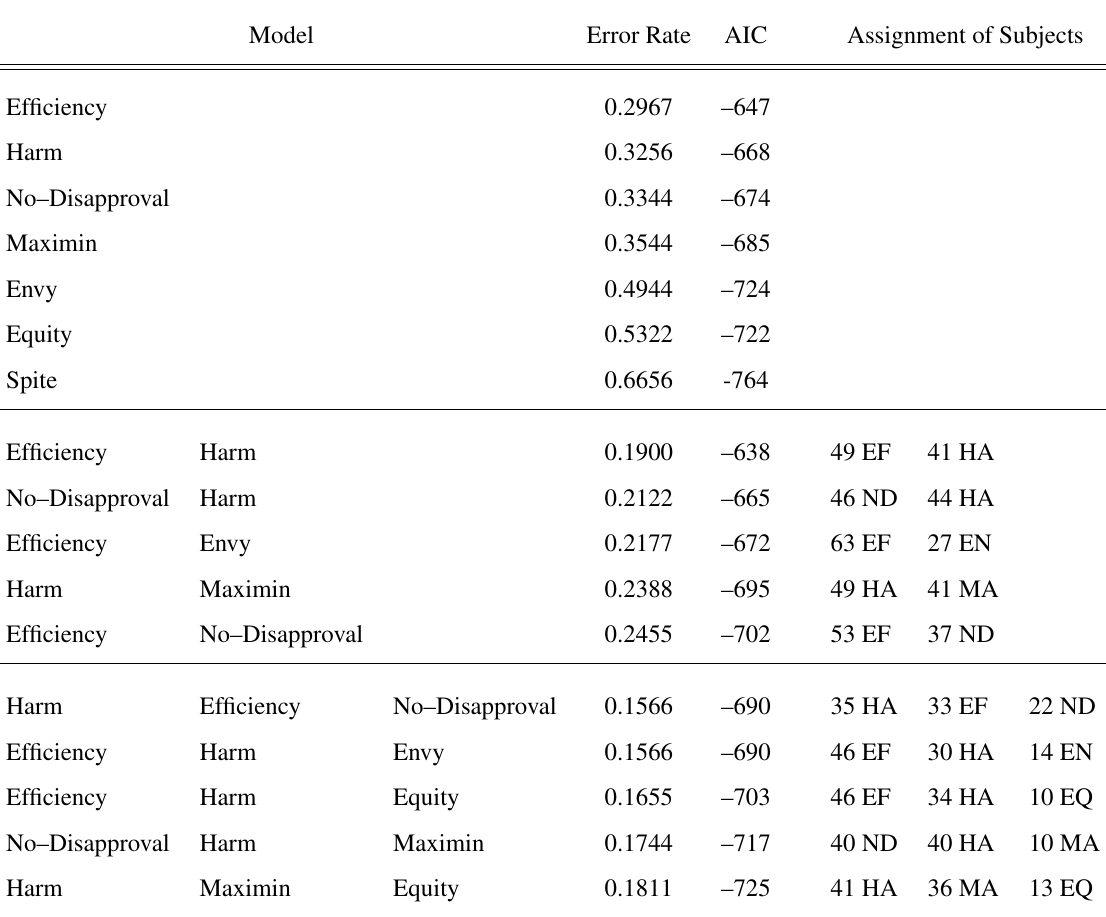
Table 3. Error rates, AIC, and the optimal assignment of subjects in the best models of 1, 2, and 3 decision rules (models with more decision rules have a very negative